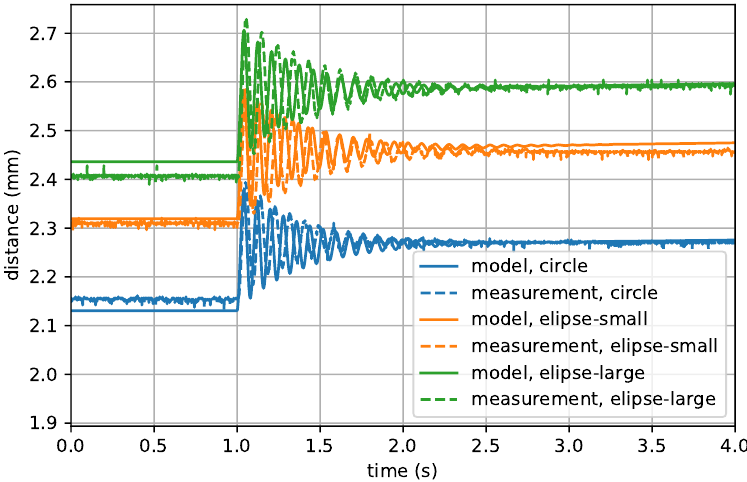
Figure 10. Response of the DEAP actuator for a step voltage signal from 0kV to 3.5kV with a load of 17.9g (zoom version).